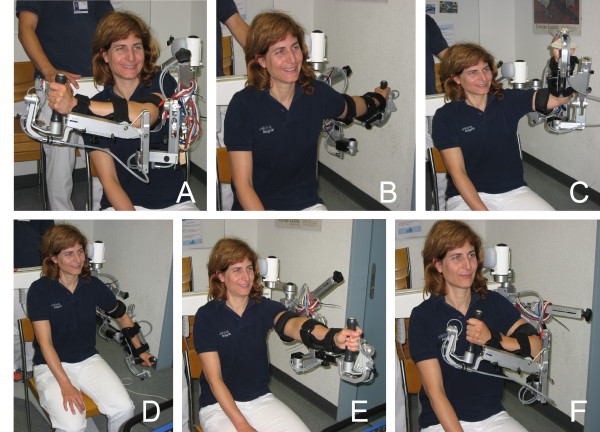
Tested arm movements and positions. Maximal reaching of a healthy subject to the A: right; B: left; C: top; D: bottom; E: far and F: close.